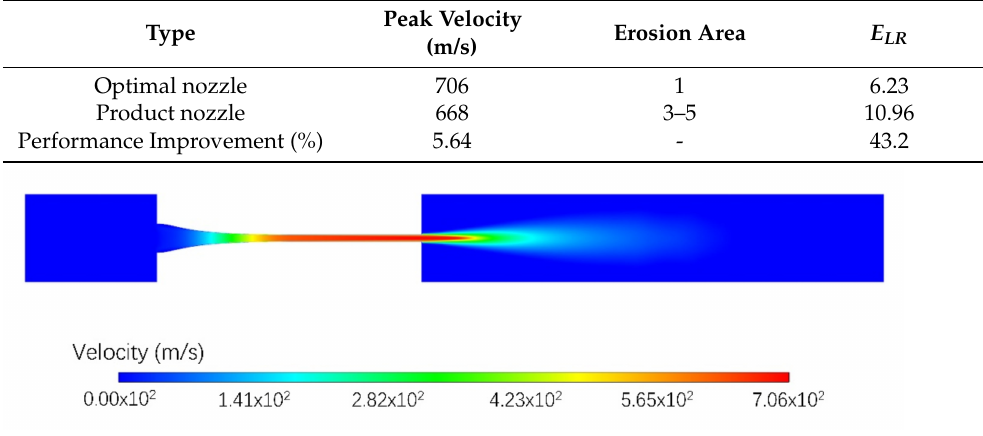
Figure 11. Velocity distribution of optimal cross-section nozzles.